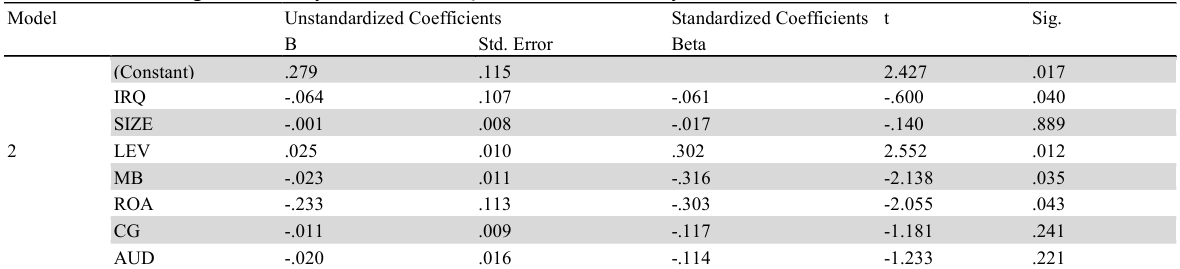
The results of the regression analysis between DQIBR and discretionary accruals Model Unstandardized